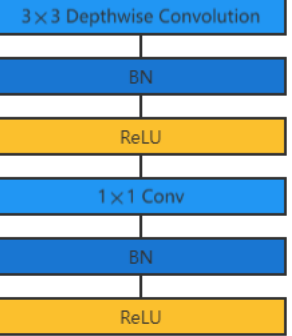
Figure 7. Illustration of deep separable convolution layer